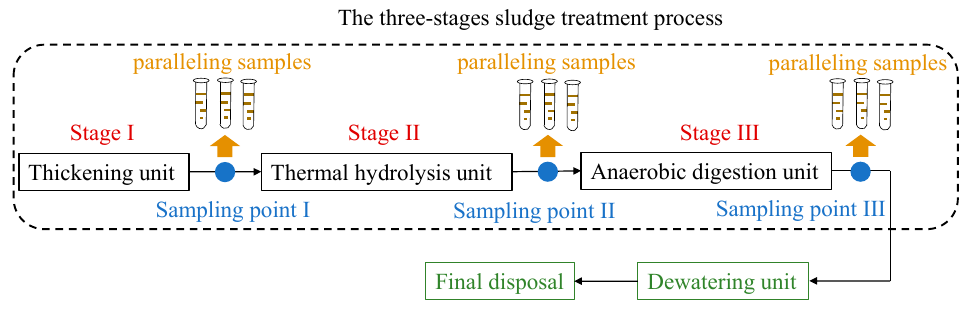
Figure 2. Sludge-treatment process and distribution of sampling points. 158